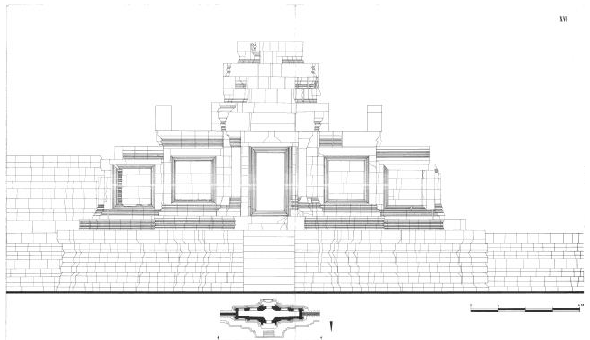
Figure 4 North elevation of the Outer North Gate of Ta Keo Temple, Angkor Monuments, Cambodia (after